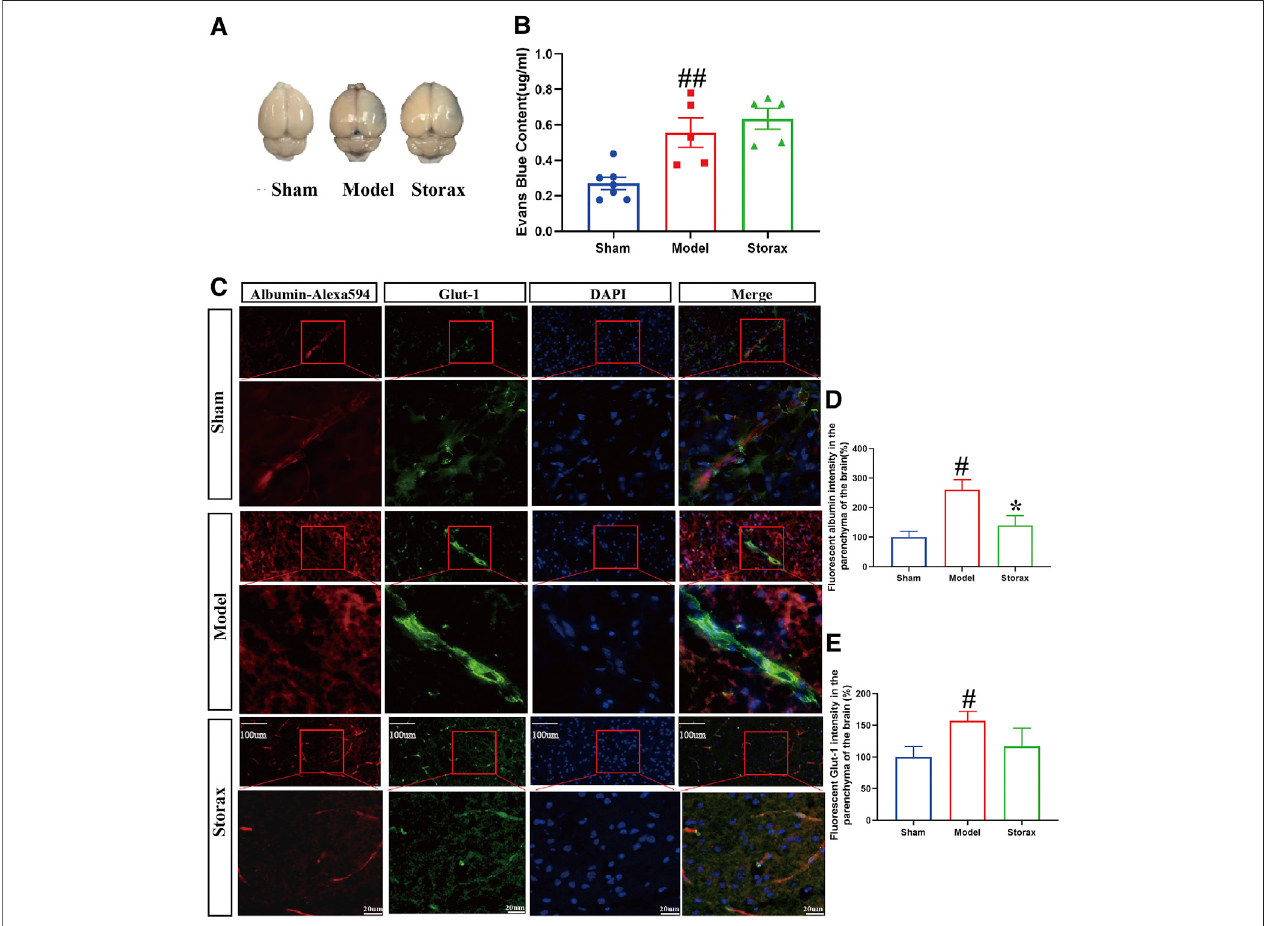
FIGURE 2 | Storax inhibits Albumin-Alexa594 leakage from BBB to brain parenchyma at 6 h after stroke. (A) Representative images of EB staining. (B) Quanti fi cationofEvansblue(EB)leakage. (C) RepresentativeimagesofAlbumin-Alexa594andGlut-1staining. (D,E) Quanti fi cationof fl uorescentAlbumin-Alexa594and Glut-1 intensity in the parenchyma of the brain. Data were shown as the mean ± SEM. # p < 0.05 vs . Control group, * p < 0.05 vs . Storax group, bar = 20 μ m and bar = 100 μ m, n = 7 for EB leakage assay and n = 3 for Albumin-Alexa594 leakage assay.